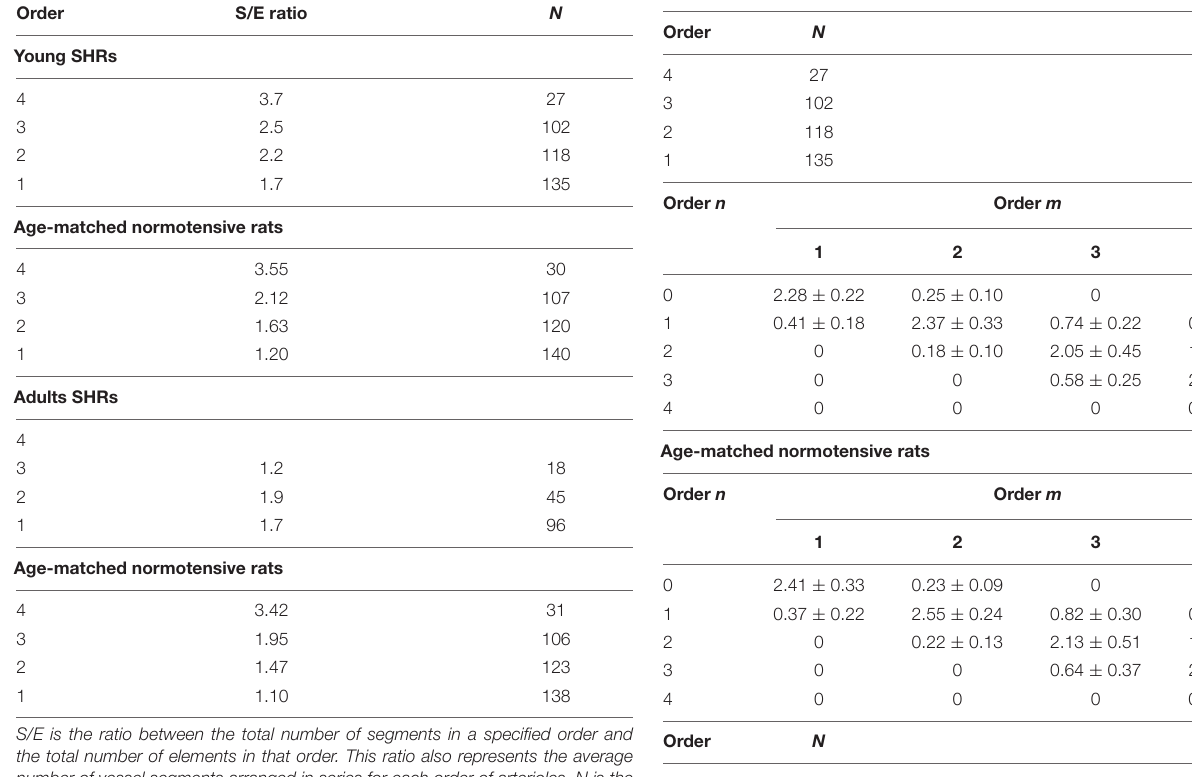
TABLE 3 | Segment and element ratios in each order of arterioles in young spontaneously hypertensive rats (SHRs) (A), in age-matched normotensive rats (B), in adult SHR (C) and in age-matched normotensive rats (D). Order